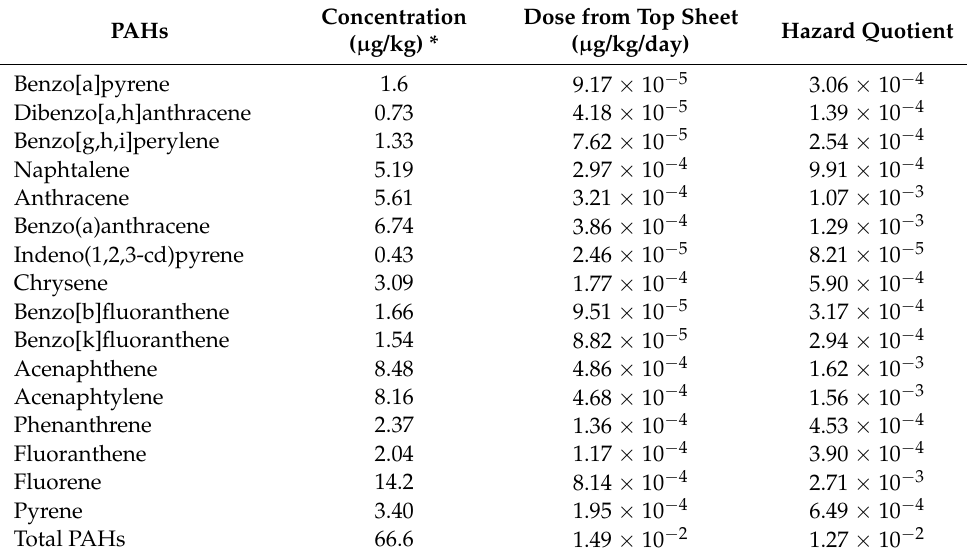
Table 5. Assessment of neurobehavioral risks of polycyclic aromatic hydrocarbons (PAHs) in the top sheet of